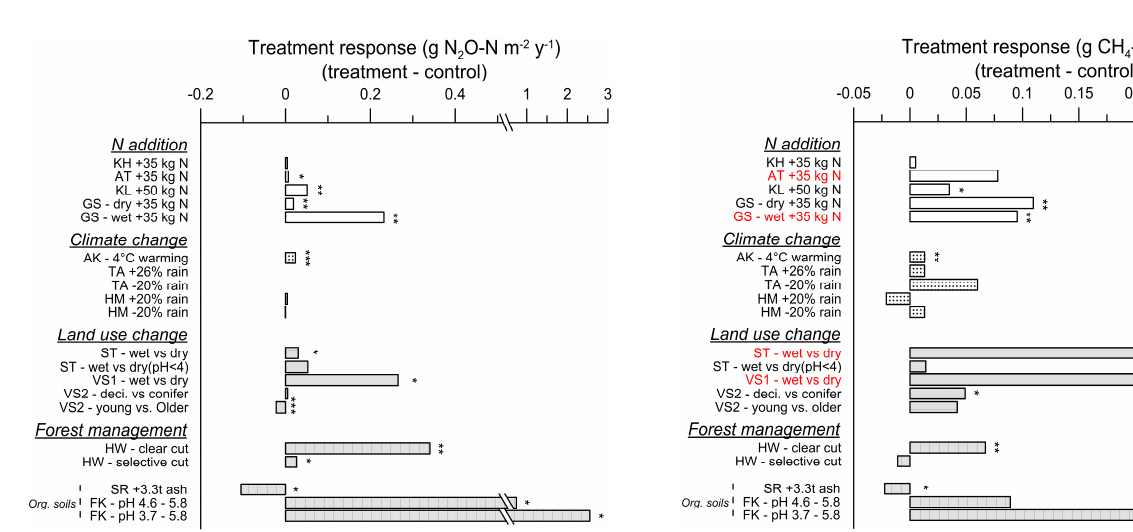
Fig. 3. Response of CH 4 gas exchange to forest change (treatment minus control). Site codes and treatments are explained in Table 1. Stars indicate the level of significance for the treatment effect. ( ∗ : p < 0 . 05; ∗∗ : p < 0 . 01; ∗∗∗ : p < 0 . 001). A positive treatment re- sponse indicates that more CH 4 is left in the atmosphere (i.e. a lower CH 4 uptake occurred in the treatments compared to the con- trols). The text in red marks the sites that had CH 4 emission (AT) or where the treatment resulted in a net CH 4 emission (GS-wet, ST and